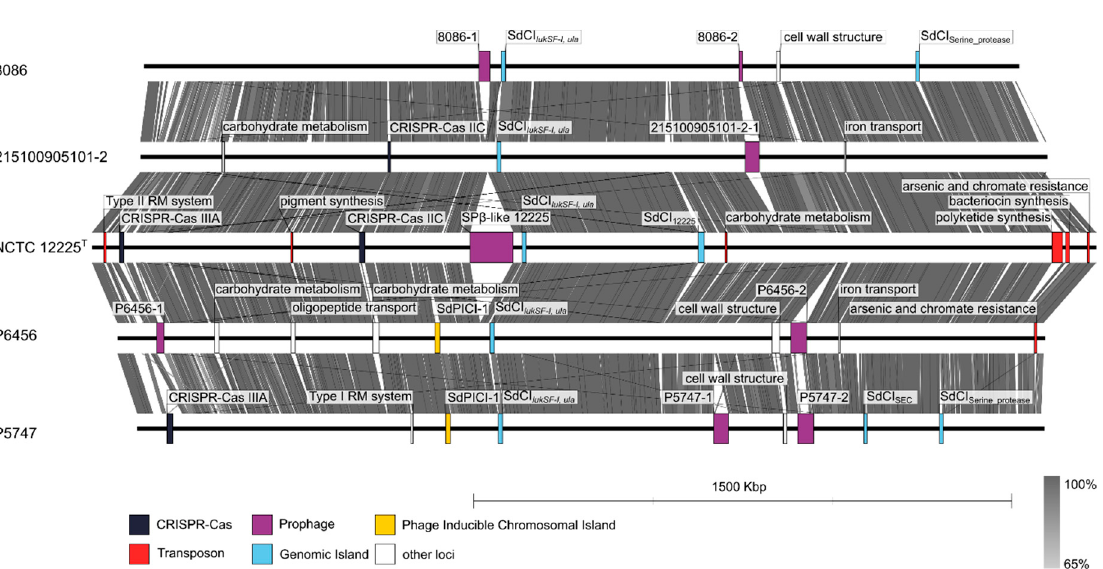
Table 3. Intergenomic distances between the genomes of Staphylococcus intermedius group strains in percent, represented by average nucleotide identity (ANI) and digitally derived genome-to-genome distances (GGD) emulating DNA–DNA hybridization values. Strain